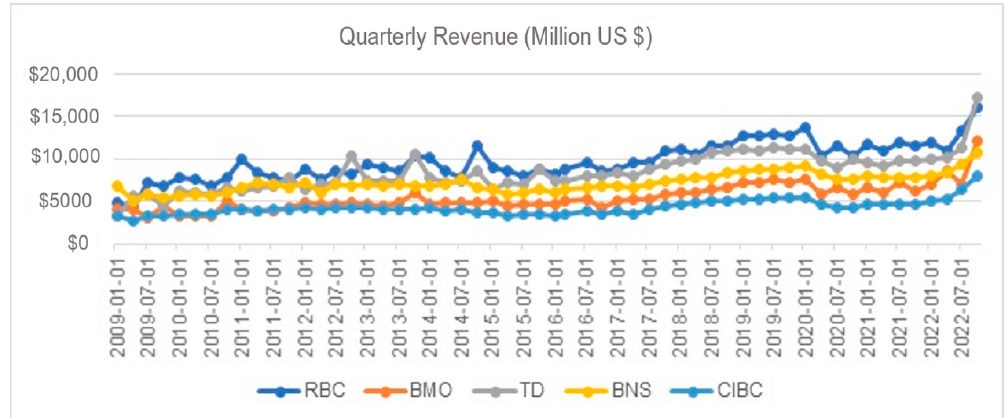
Figure A3. Quarterly revenue of the five banks (Source: Data 2 n.d. https://www.macrotrends.net/ stocks/charts, accessed on 12 December 2022).